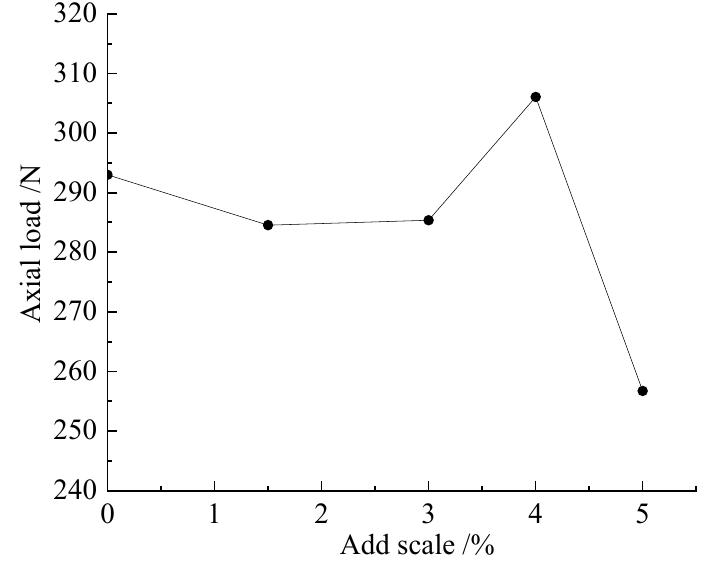
Figure 10. M ‐ L scheme sample: ratio of lignin addition and axial load. Figure 10. M-L scheme sample: ratio of lignin addition and axial